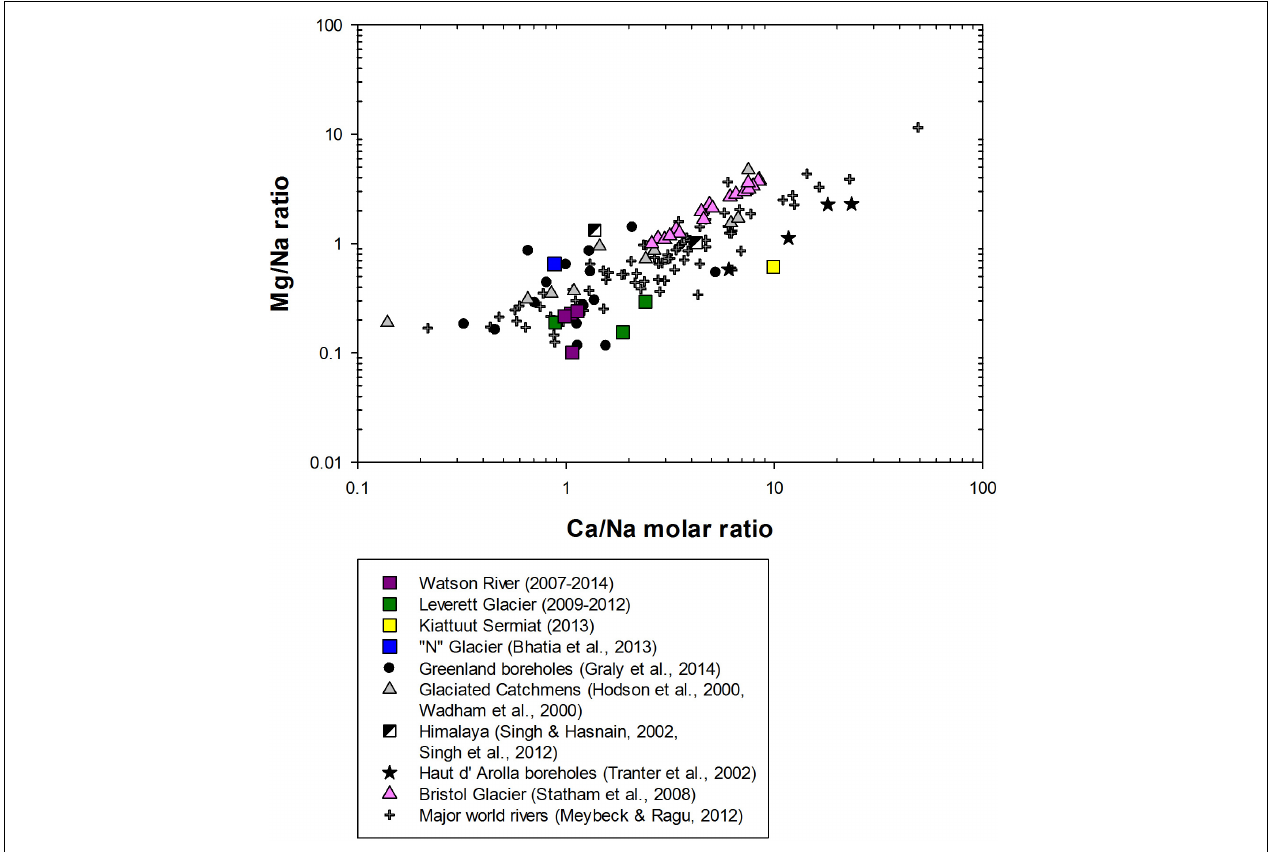
FIGURE 4 | Mixing diagram using dissolved Na-normalized molar ratios in dissolved in meltwaters from glaciated catchments and major world